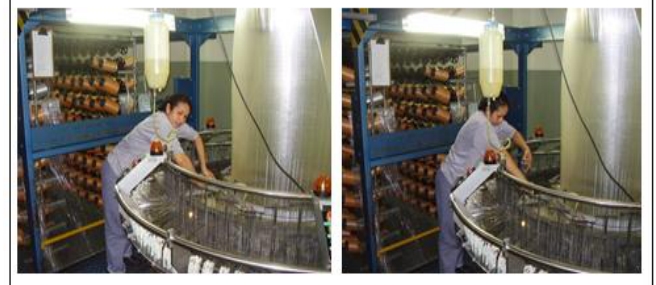
Figura 6: Posição inadequada prejudicando a coluna lombar.